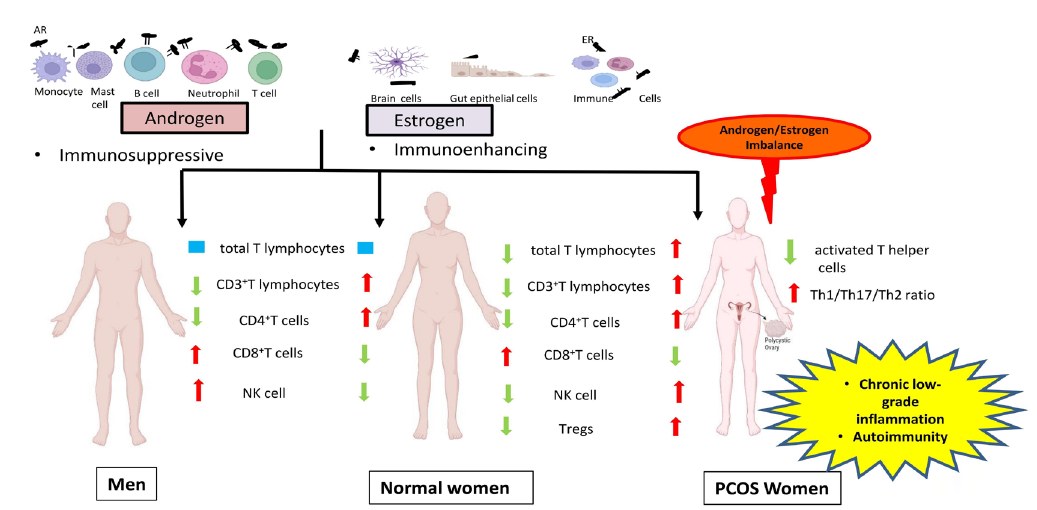
Figure 1. Schematic representation of the role of sex steroids in the immune system of normal women, men and PCOS by comparing the immunologic features of PCOS women and men with normal women. ER: estrogen receptor; NK: natural killer; Tregs: regulatory T